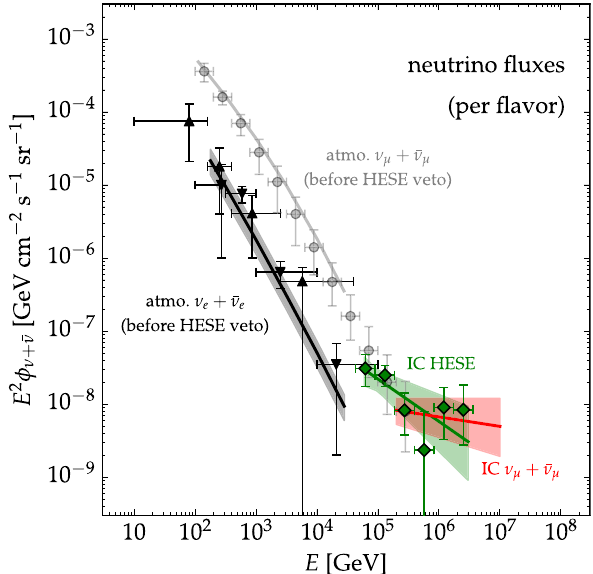
Fig. 3 AnillustrationofneutrinodetectionwithIceCubelocatedatthe South Pole. Cosmic ray interactions in the atmosphere produce a large background of high-energy muon tracks (solid blue arrows) in IceCube. This background can be reduced by looking for up-going tracks pro- duced by muon neutrinos (dashed blue arrows) that cross the Earth and interact close to the detector. The remaining background of up-going tracks produced by atmospheric muon neutrinos can be further reduced by energy cuts